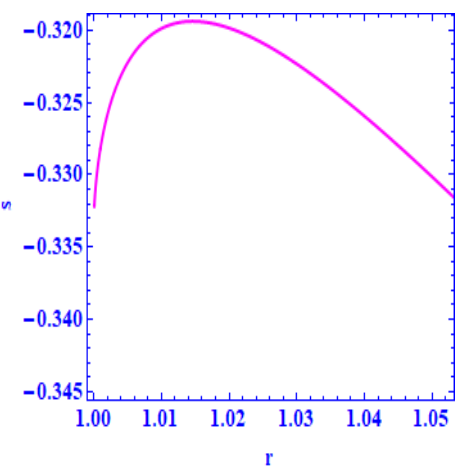
Figure 11. Plot of s versus z .